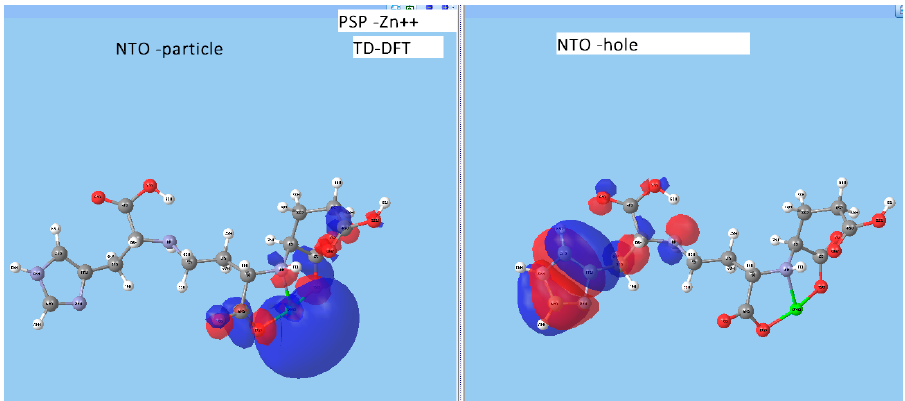
Figure 5. HOMOs and LUMOs of complexes of pseudopaline with divalent Ni and Zn.